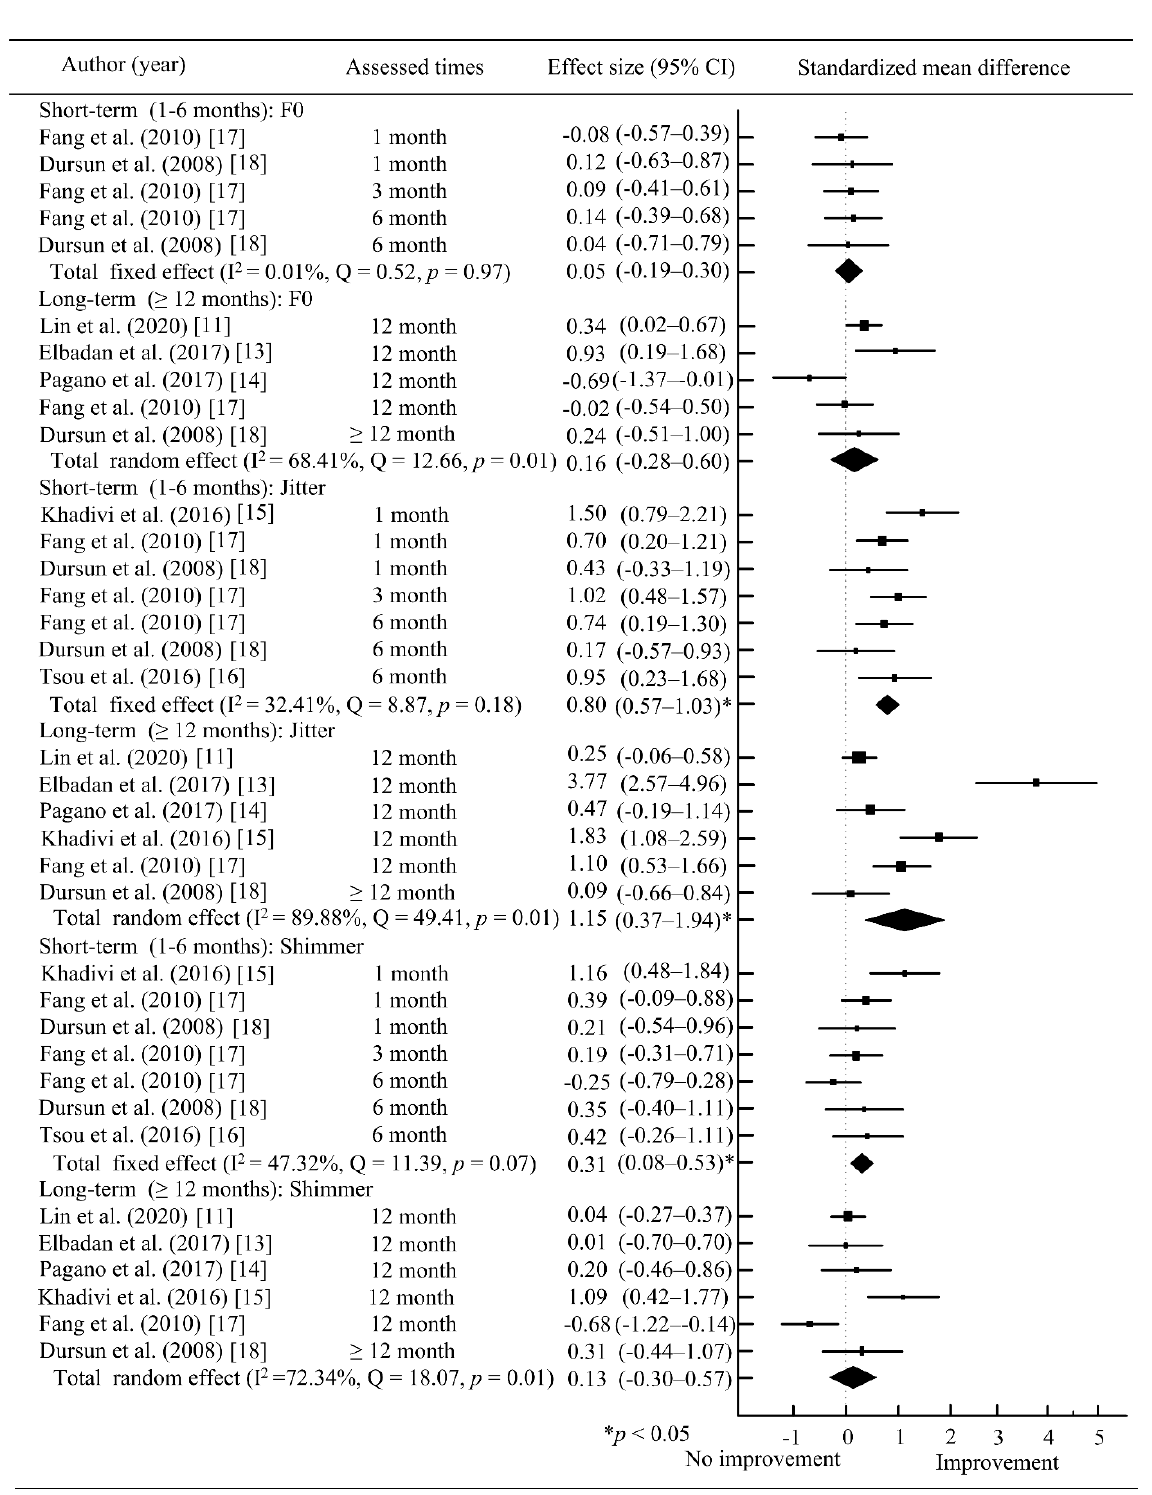
Figure 4. Meta-analysis of voice parameters (F0, jitter, and shimmer) after AFIL. * p < 0.05; ■, SMD; ◆ total SMD.